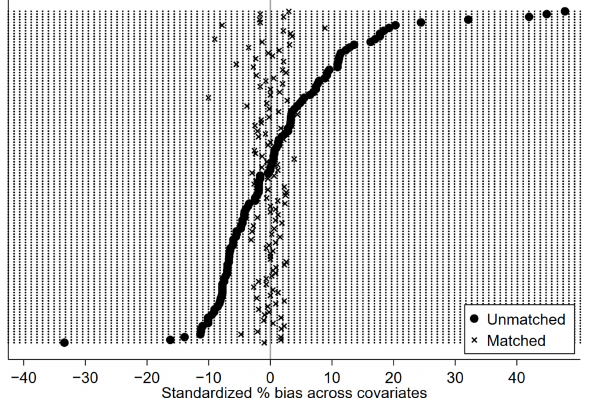
Figure 3. Distribution of standardized percentage bias across covariates between groups before and after matching. Note: due to the large number of county variables, the ordinate does not list all the variable